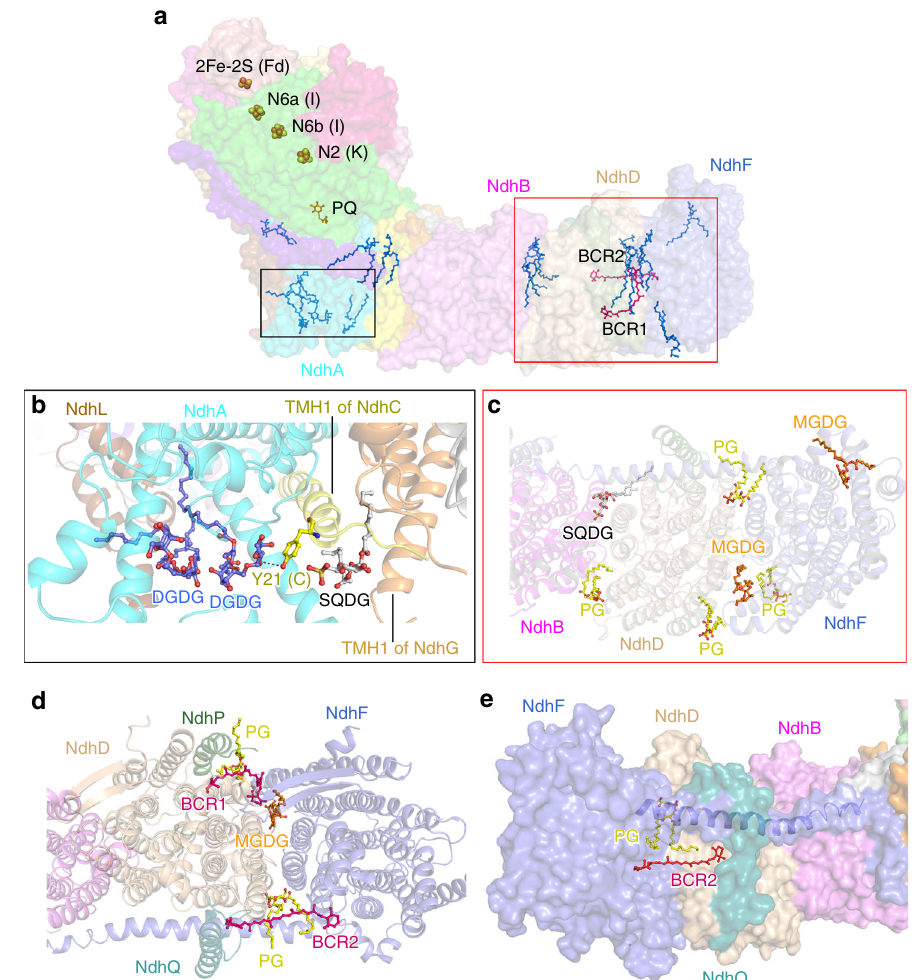
Fig. 2 The membrane arm with lipid and carotenoid molecules. a Distribution of cofactors in NDH-Fd structure. Fe – S clusters are shown as spheres, PQ (orange), lipids (blue), and carotenoids (red) are shown as sticks. b Three lipid molecules (shown as ball-and-stick mode) contribute to the stabilization of NdhL, NdhA, NdhC, and NdhG. c The stromal side view of the lipid distribution at the distal part of the membrane arm. d Two carotenoid (BCR) and three lipid molecules participate in NdhF – NdhD interactions. e The binding pocket of BCR2. The color codes of subunits are the same as those in Fig. 1. The horizontal helix of NdhF is shown as blue cartoon. The BCR molecules are shown as red sticks. Lipid molecules are colored yellow for phosphatidyl glycerol (PG), gray for sulfoquinovosyldiacyl glycerol (SQDG), orange for monogalactosyldiacyl glycerol (MGDG), and blue for DGDG in b – e